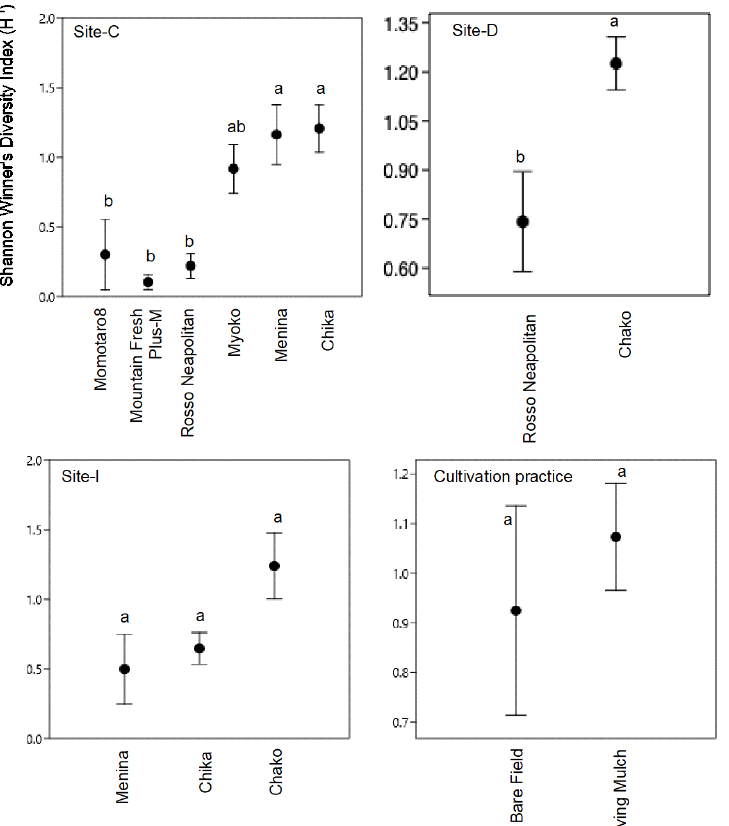
Figure 5. Fungal endophyte biodiversity analysis. The effects of host cultivar and cultivation practice on fungal endophyte biodiversity as measured by the Shannon–Wiener index (H’). Endophytes were isolated from the stems of different tomato cultivars grown under nature farming conditions and sampled from three experimental sites in INFRC. The Within each site, different letters (a,b) above the bars indicate significant differences ( p < 0.05, ANOVA and Tukey’s HSD tests).